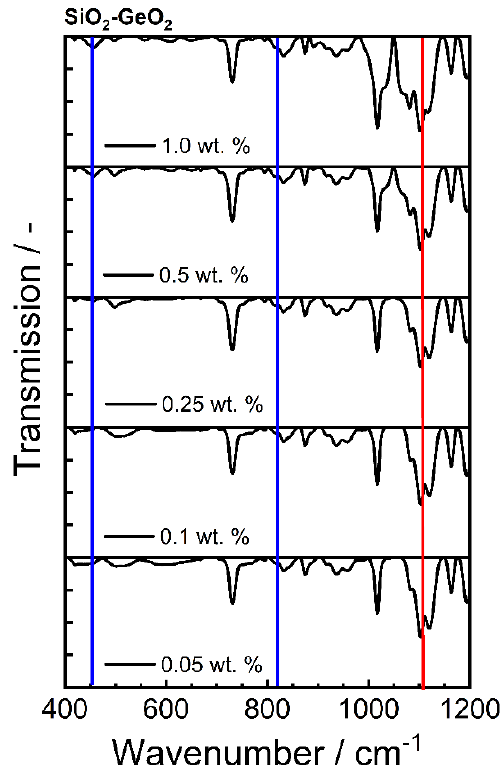
Figure 11. IR spectra of the different PBT ‐ PC ‐ SiO 2 ‐ GeO 2 blends. Bands are taken from Table 6, blue represents GeO 2 bands and red represents the SiO 2 band.